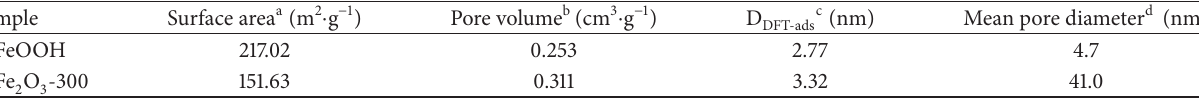
Table 1: The textural properties of the as-prepared catalysts.